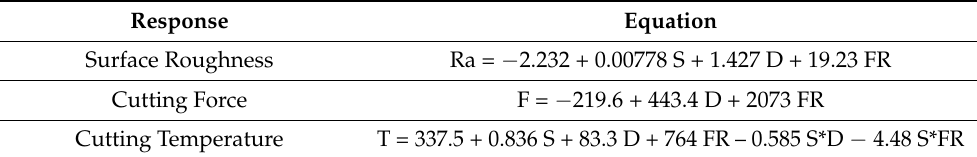
Table 7. Mathematical equations for the measured responses.